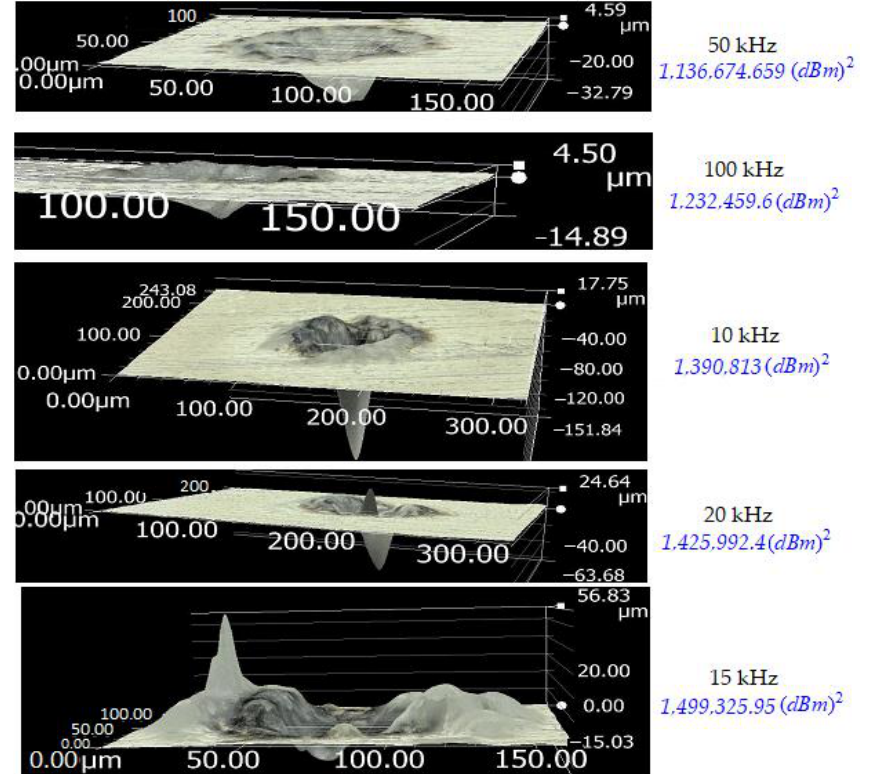
Figure 4. 3D microscopic images (left-hand side) and the values of the recorded RFP 2 (dBm) 2 , written in the colour blue (right-hand side), for the received RF spectra of the “Part 1” experiments. As shown here, the RFP 2 is displayed running from its lowest recorded value to its highest value. The values “50 kHz”, “100 kHz”, etc., refer to the repetition rate of laser ( RRL ).